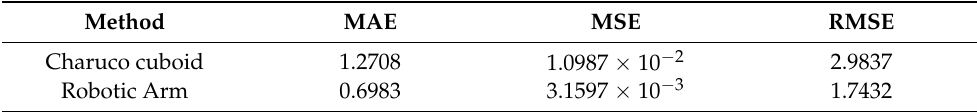
Table 3. Summary results for cuboid and TCP reconstruction with MAE, MSE, and RMSE for filtered